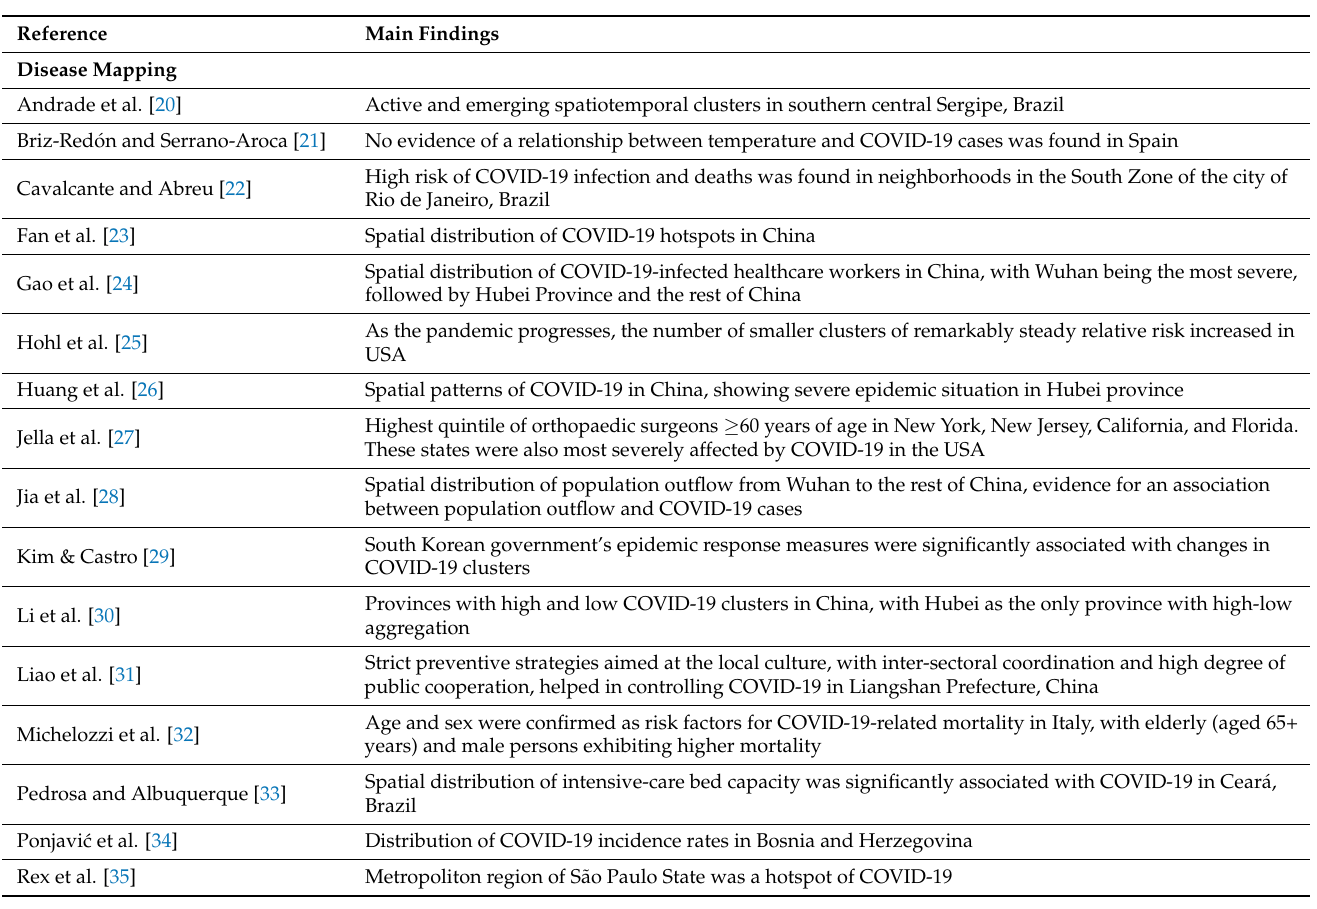
Table 2. Second-stage screening records and main study